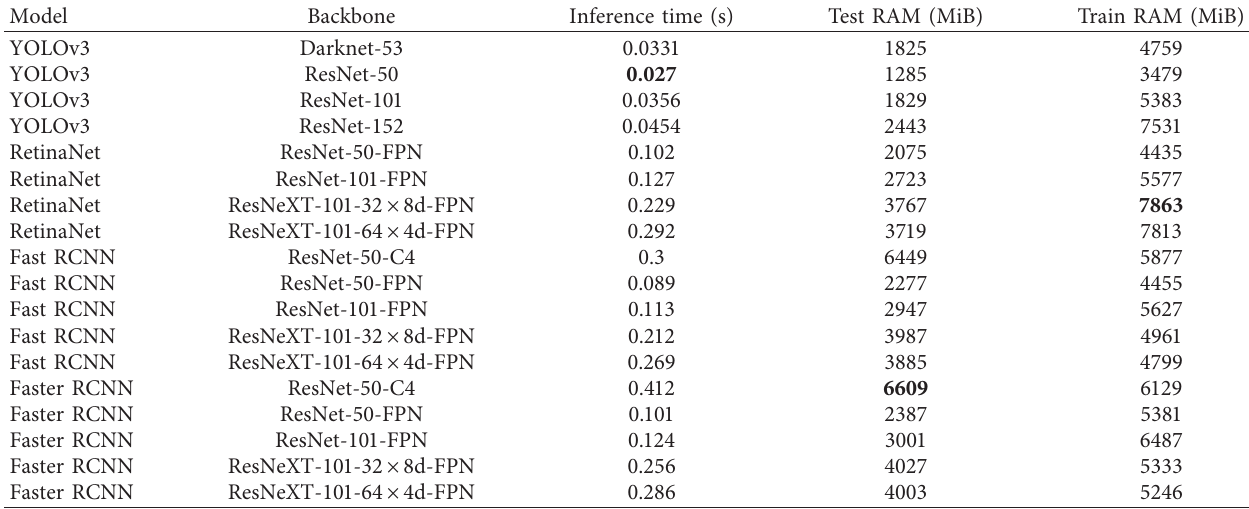
Figure 5: Highlight of bounding boxes from comparative backbones on small object dataset. We here select YOLO with Darknet-53 and ResNet-50 for objective comparison because there have obviously the same layers in their networks along with the significant techniques such as skip connections and residual blocks. The bounding boxes show that ResNet-50 has the sensitivity to areas which resembles the objects of interest than Darknet-53. Similarly, ResNet-50-FPN and ResNet-50-C4 are chosen to consider. The detection shows that combining ResNet-50 with FPN outputs a better performance rather than the original one. Particularly, misdetection happens in more density than ResNet-50-FPN such as in columns 4 and 5. Zoom in to see more Table 5: The comparison of consumption on small object dataset.